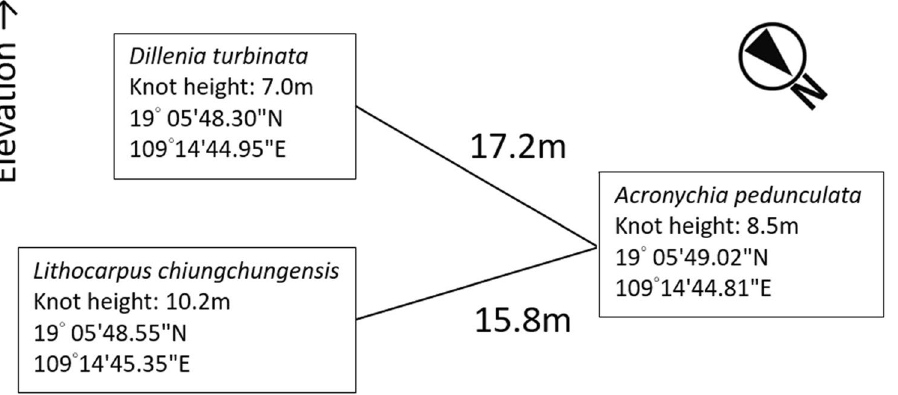
Figure 7. A schematic diagram of the canopy bridge for Hainan gibbon showing GPS coordinates, rope length, knot height and species of supporting